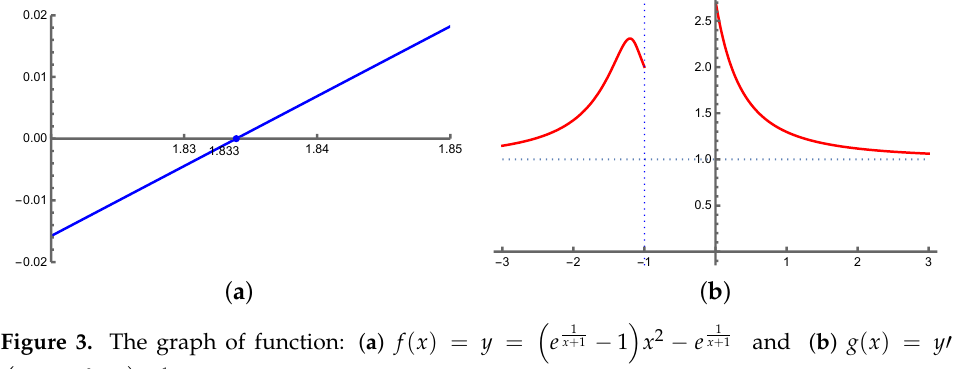
Figure 3. The graph of function: ( a ) f ( x ) = y = (cid:16) (cid:17) e 1 x + 1 − 2 x 2 x − x 2 − 1 ( x + 1 ) 2